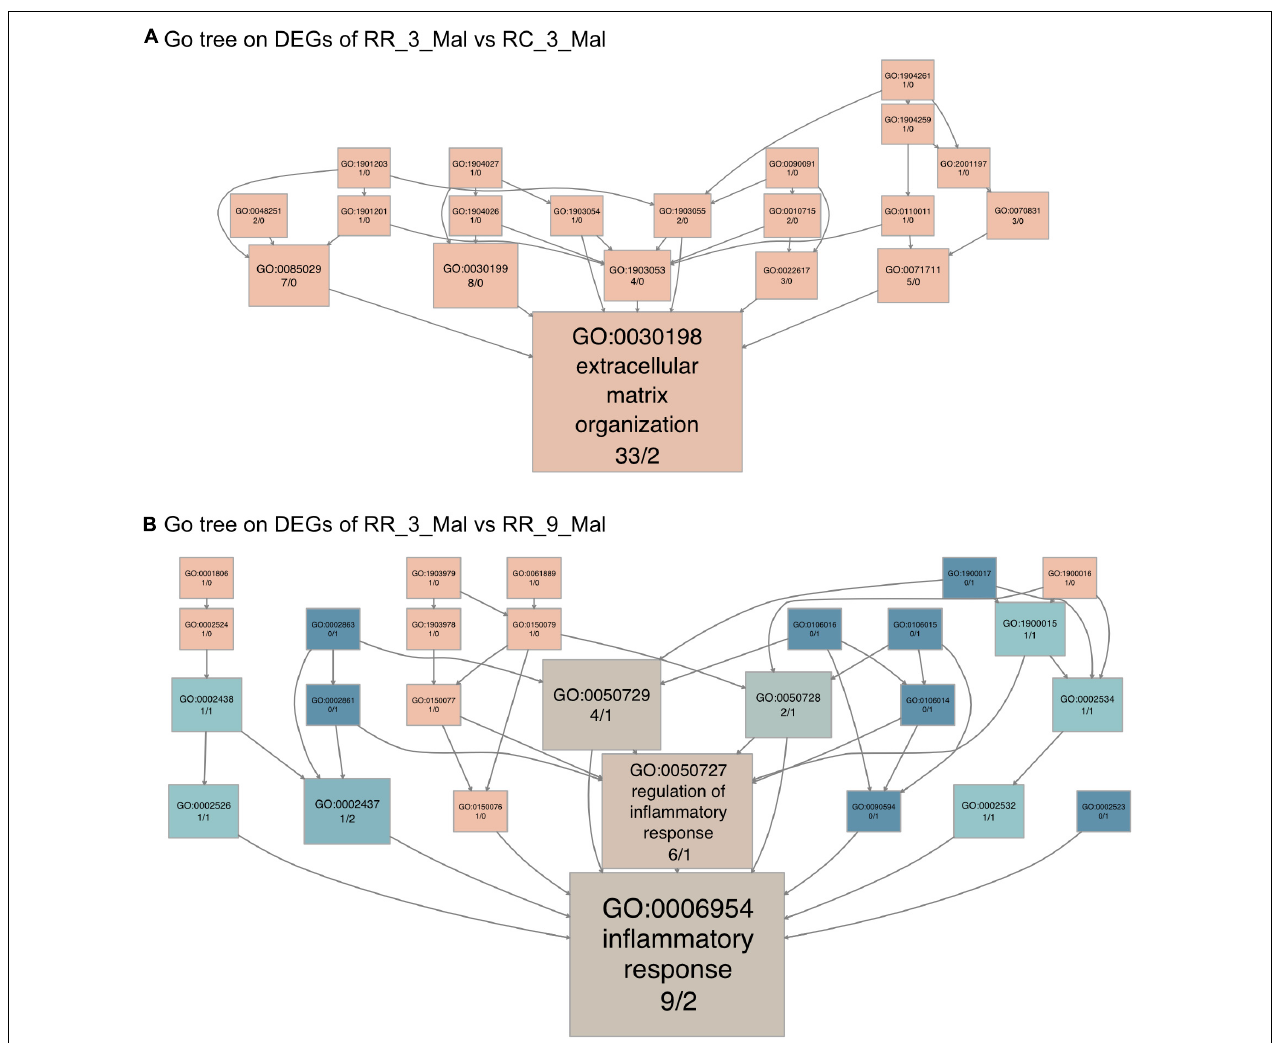
FIGURE 6 | Continuous low-protein diet leads to long-term skeletal muscle dysfunction. (A) The GO tree of 35 extracellular matrix-related DEGs in an extracellular matrix organization (GO:0030198). (B) The GO tree of 11 inflammatory-related DEGs in inflammatory response (GO:0006954). The box color equated to the numbers of upregulated and downregulated DEGs, with upregulated represented by pink and downregulated equaling